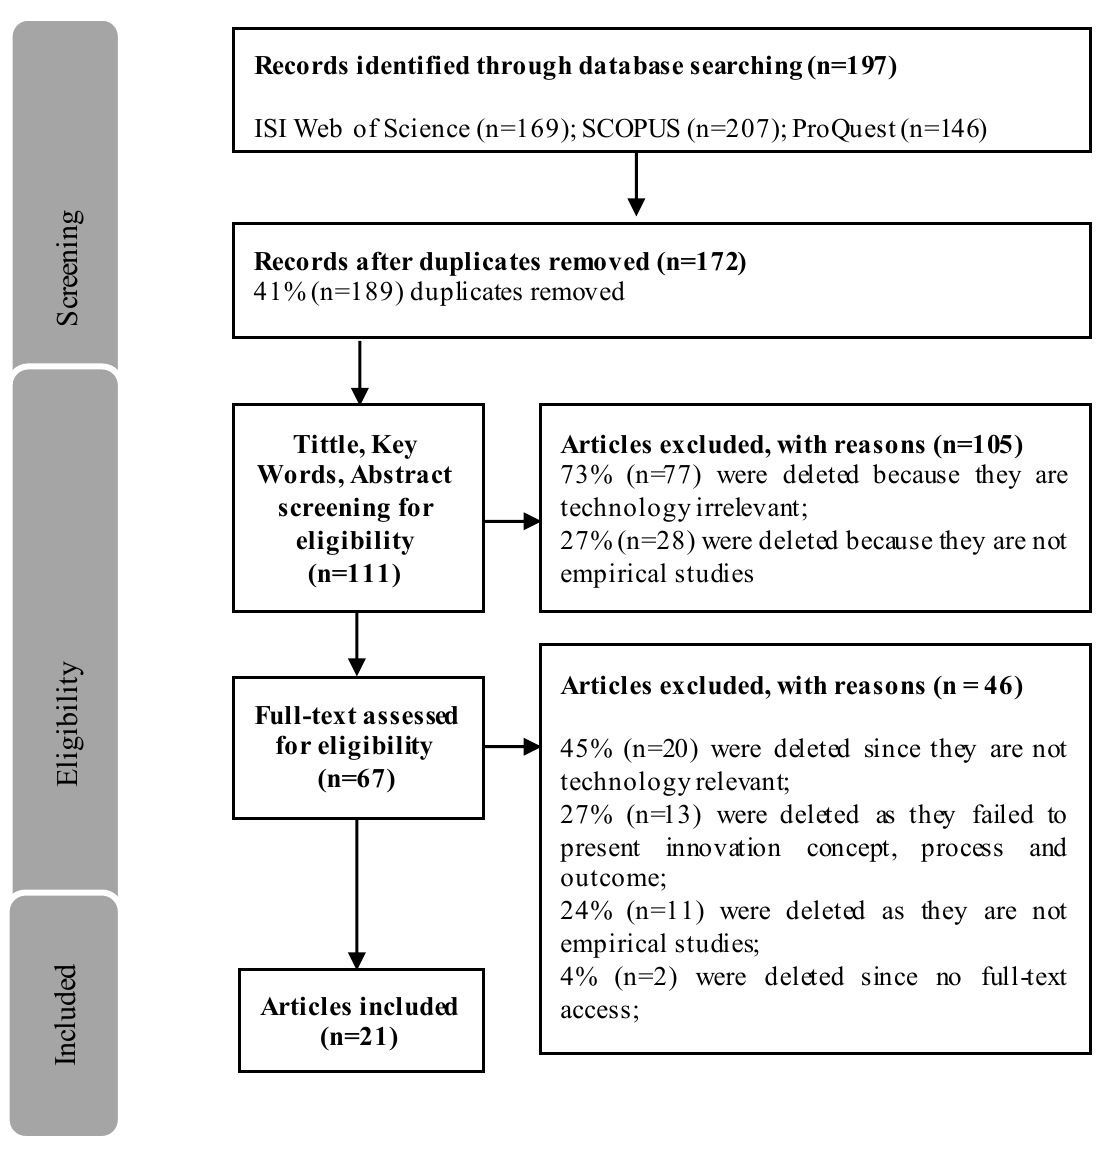
Fig. 3. PRISMA Flow